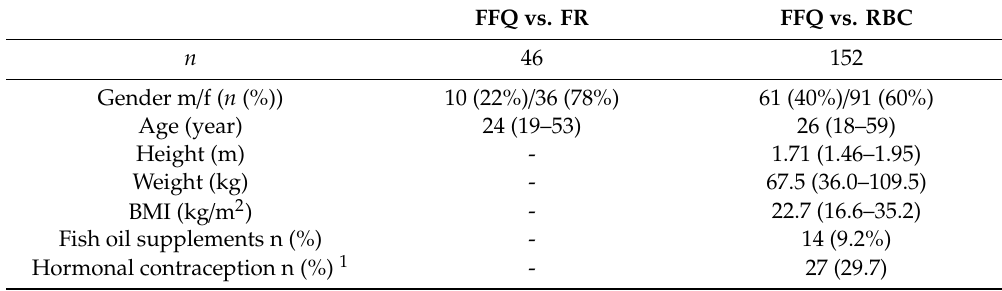
Table 1. Characteristics of the participants for the validation of an adapted food frequency questionnaire (FFQ) against 7-day weighed food records (FR) and red blood cell (RBC) fatty acid composition. FFQ vs. FR